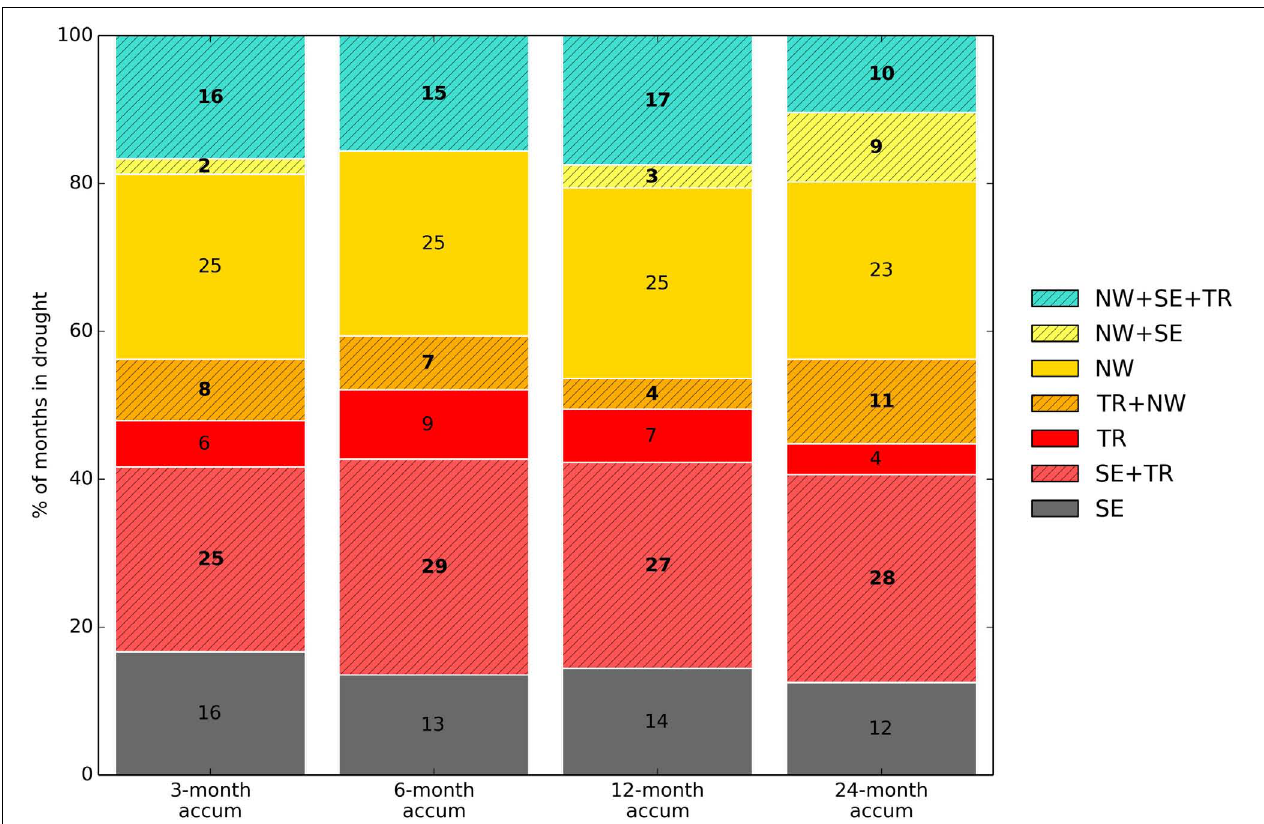
FIGURE 12 | Percentage of months in drought affecting the three regions. The hatched area represents months in drought where multiple regions were affected simultaneously. “TR” in the legend stands for the Transition region. This includes all drought events detected between 1862 and 2015, for accumulation periods of 3, 6, 12, and 24